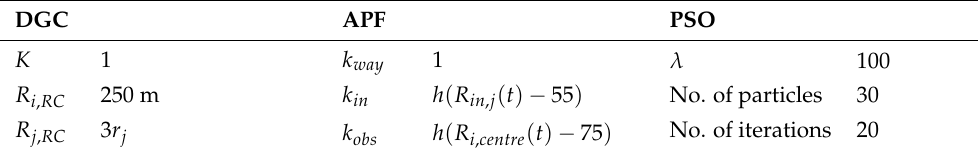
Table 1. Simulation parameters.